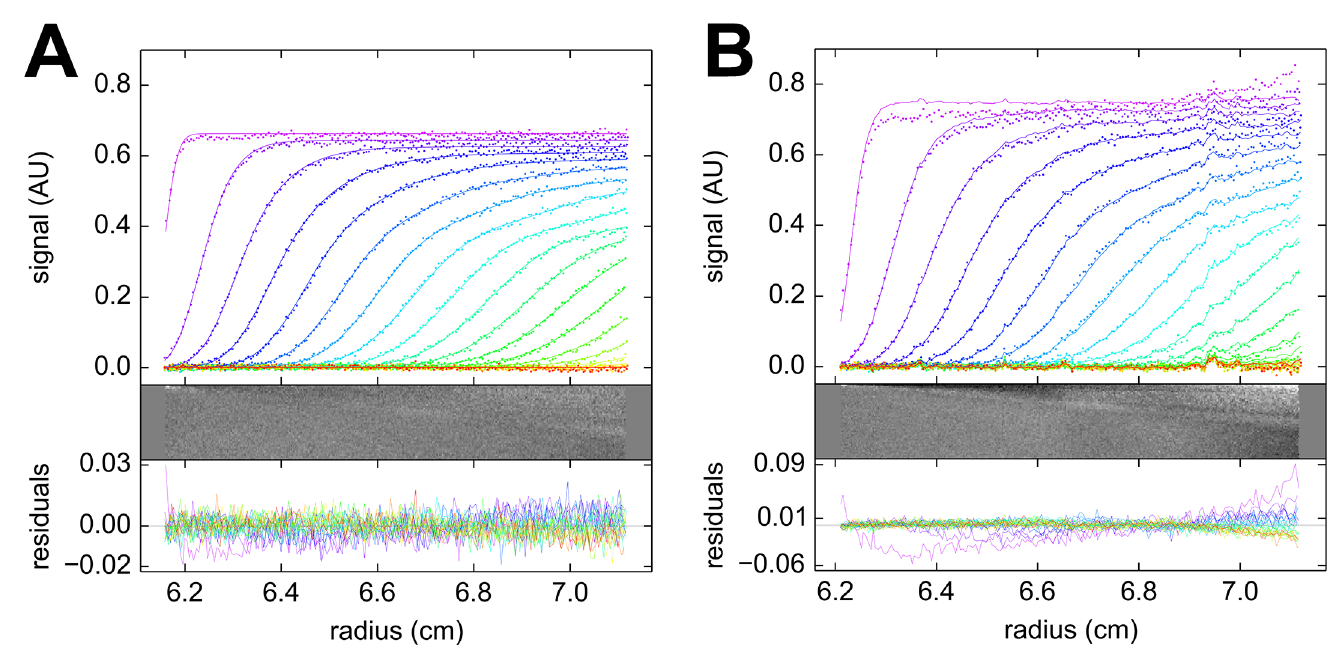
Fig 4. Sedimentation velocity experiment in rectangular cell. Sedimentation velocity analysis of bovine serum albumin sedimenting at 50,000 rpm in acrylic centerpieces with a sector-shaped (A) and rectangular shaped (B) solution column. The protein sample was identical in both. The upper panel shows the sedimentation boundaries (points, for clarity, only every 2 nd data point of every 2 nd scan is shown), along with the best-fit c ( s ) profiles (solid lines). Below are the residuals of the fit as bitmap and overlay plot. The c ( s ) distribution for both data sets are shown in Fig